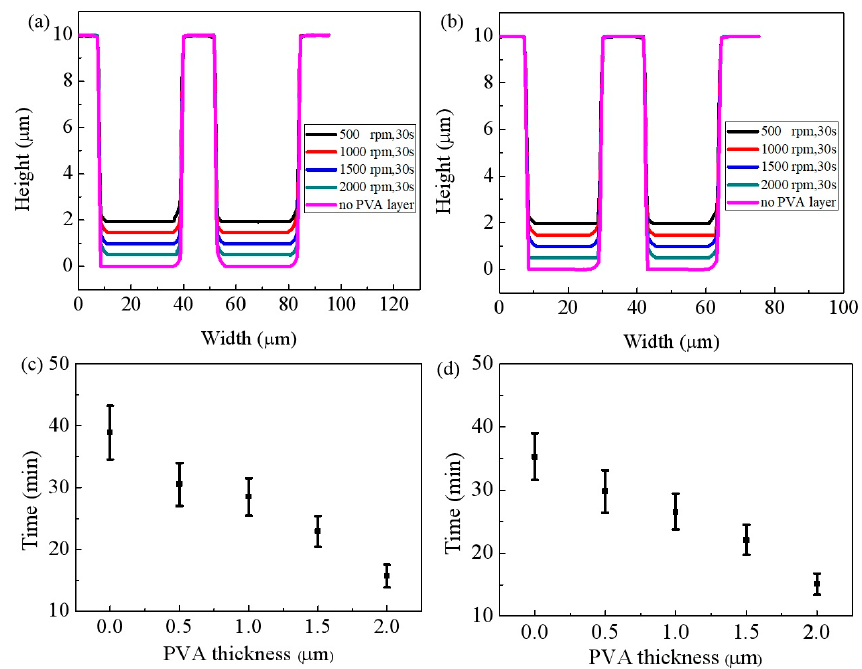
Figure 7. Influence of different mold shapes: ( a ), ( b ) Surface profiles of 60 μ m × 30 μ m size and 60 μ m × 20 μ m size PDMS molds after spin-coating PVA at different speeds; ( c ), ( d ) the release time of PCLC flakes in 60 μ m × 30 μ m size and 60 μ m × 20 μ m size PDMS molds with different PVA layer